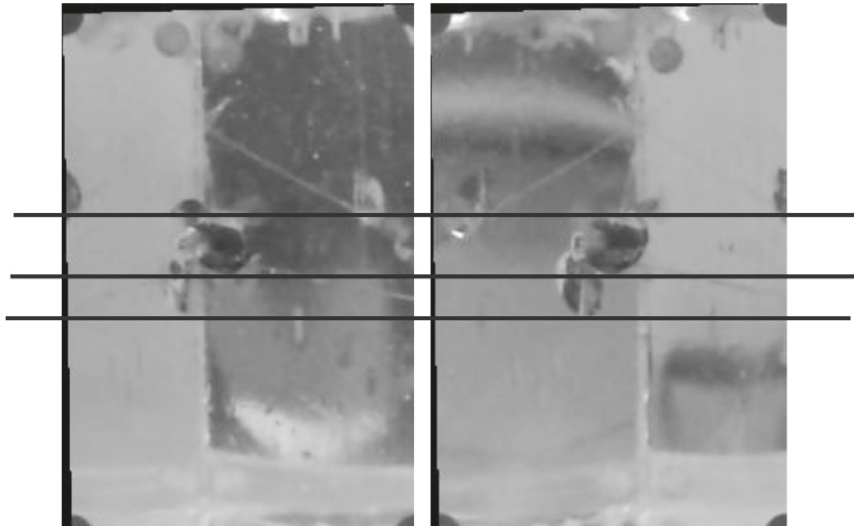
Figure 14: The rectified result by the refractive geometry